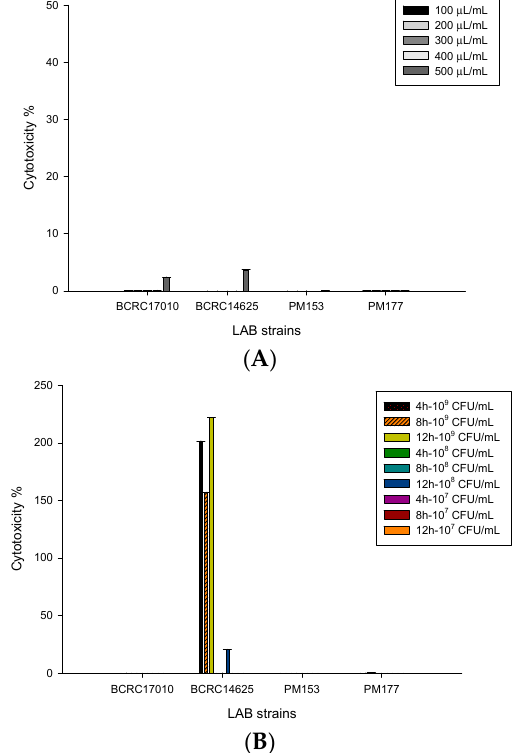
Figure 2. ( A ) Measurement of cytotoxicity on HT-29 cell line by lactic acid bacteria supernatants after 24 h incubation; ( B ) Measurement of cytotoxicity (%) on HT-29 cell line by lactic acid bacteria strains after 4, 8, 12 h incubation. cytotoxicity (%) = [(Experimental OD 490 − Spontaneous negative control OD 490 )/Maximum LDH release positive control OD 490 ] × 100.